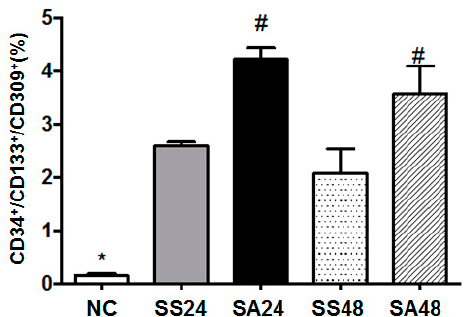
Figure 1. Distribution of circulating proangiogenic cells (CD34+/CD103+/CD309+) among the normal control (NC), sepsis with saline 24 h post-cecal ligation and puncture (CLP) (SS24), sepsis with arginine 24 h post-CLP (SA24), sepsis with saline 48 h post-CLP (SS48), and sepsis with arginine 48 h post-CLP (SA48) groups. All data are representative of duplicate measurements ( n = 8). Data are presented as the mean ± SD. * Significantly differs from the sepsis group. # Significantly differs from the SS group at the same time point ( p < 0.05).